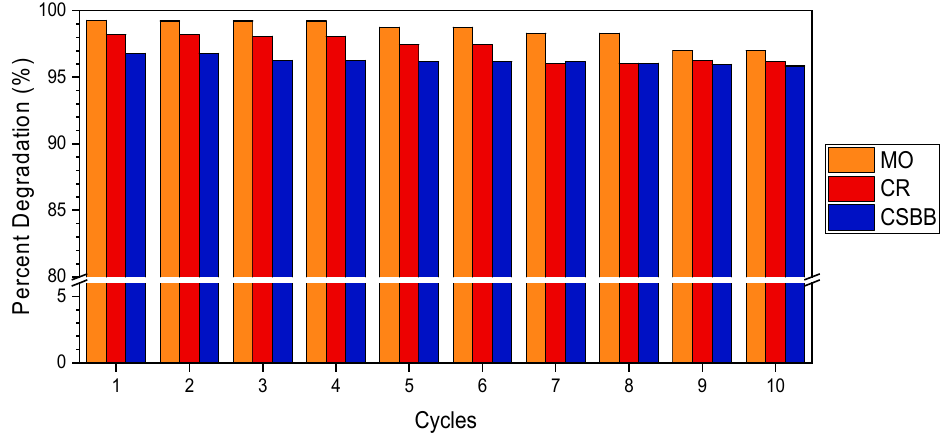
Figure 7. Catalytic activity of Ag NP–cotton catalyst against consecutive degradation reaction cy- cles.